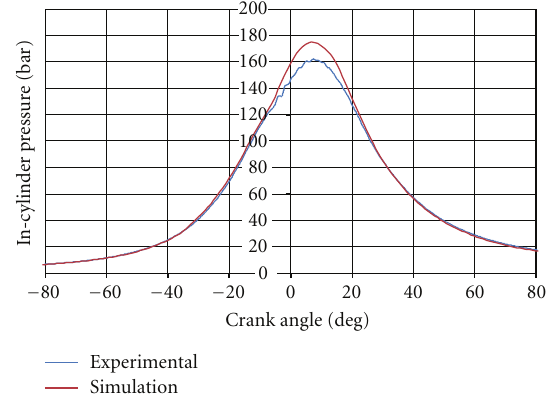
Figure 6: Comparison of experimental and simulated values of peak firing